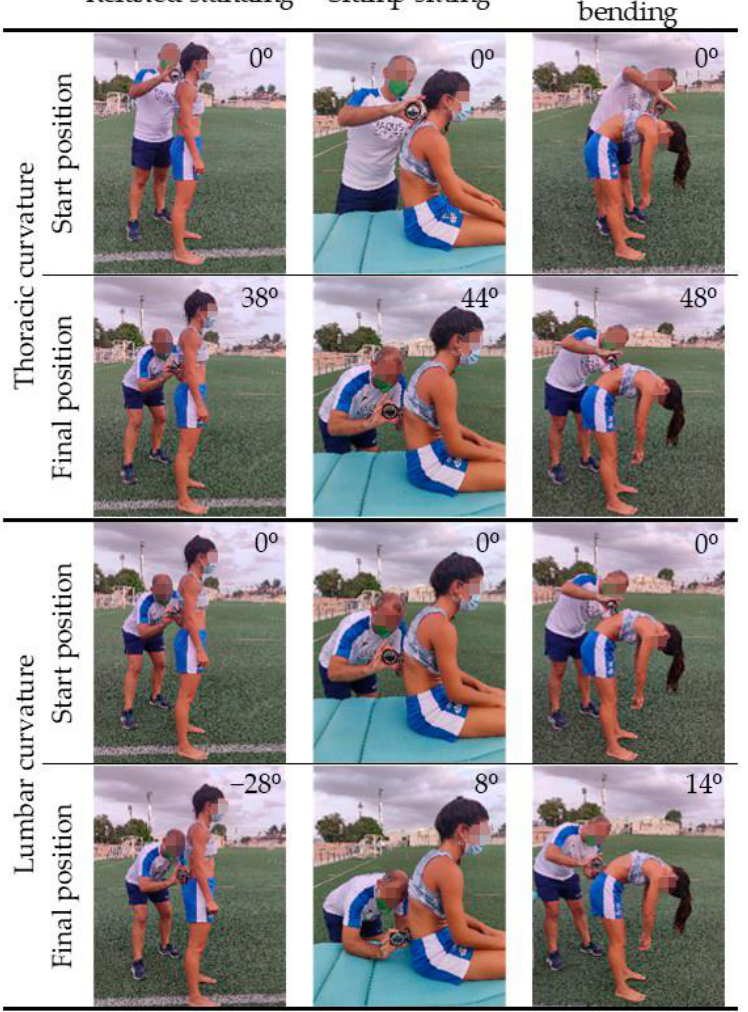
Figure 2. Assessment of sagittal thoracic and lumbar curves.